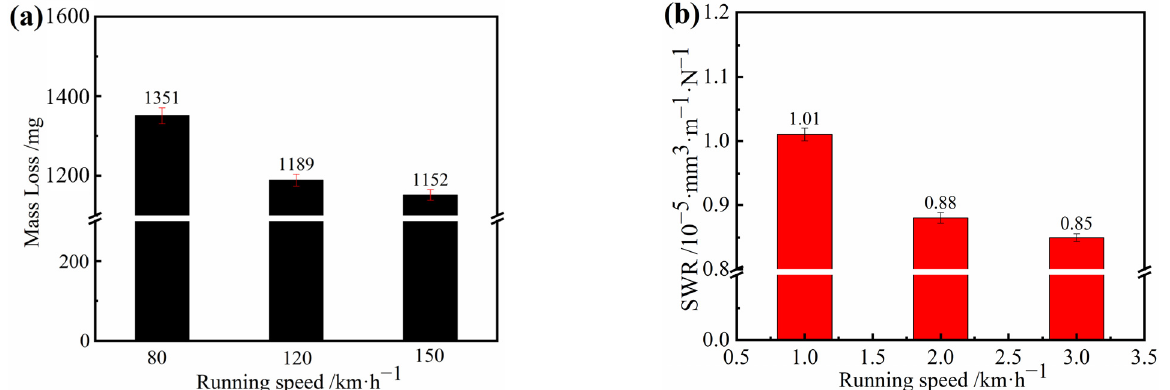
Figure 4. Wear loss of the wheel specimens with increasing running speed: ( a ) Mass loss and ( b ) specific wear rate.